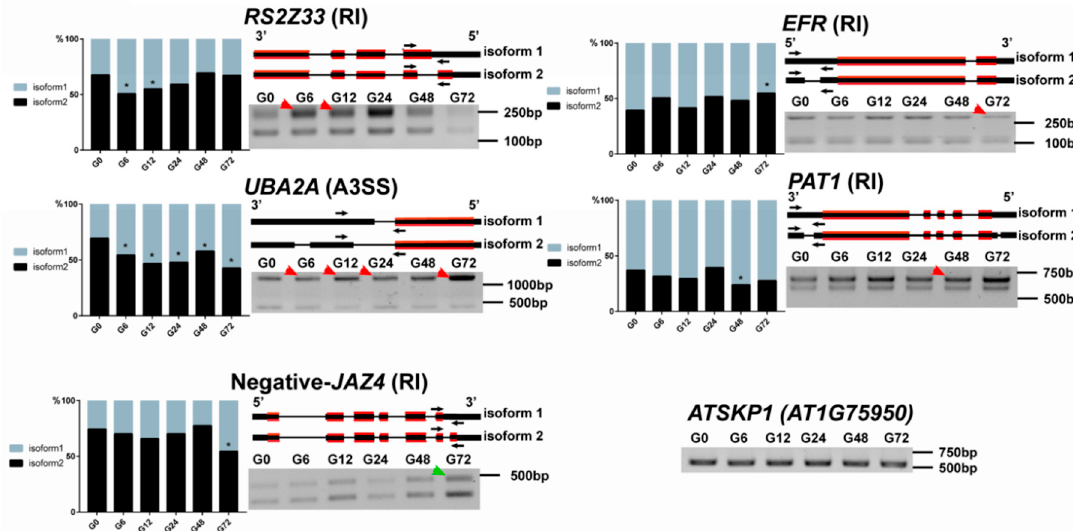
Figure 6. Experimental validation of defense-related events by reverse transcription (RT)-PCR in Arabidopsis thaliana . The bar charts show the relative percentages of isoform1 and isoform 2 during R. solanacearum infection according to IncLevel values. The asterisks show the significance compared to 0 h (G0). For the transcripts model, the red lines represent the coding areas and black arrows represent the RT-PCR primer binding sites. ATSKP1 ( AT1G75950 ) was used as an internal reference for normalization. Red arrows in the RT-PCR results show the consistency between the results and bar plots, while the green arrow shows the